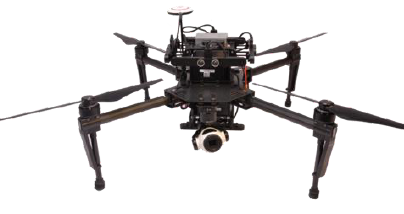
Figure 2: UAV system provided to all State Remote Sensing Centres of North Eastern Region